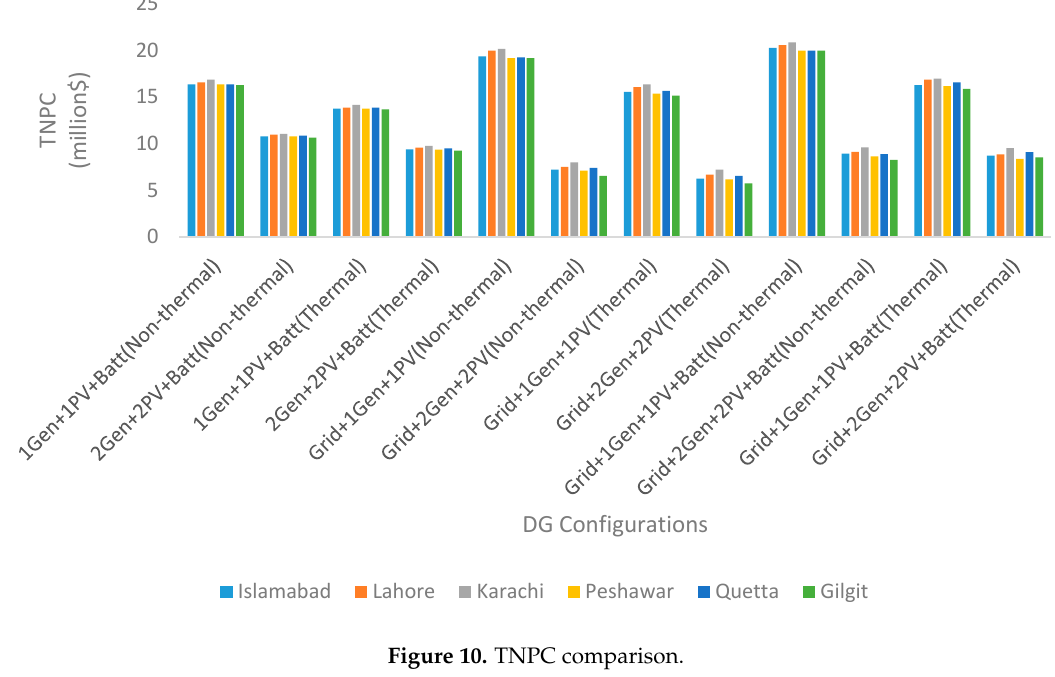
Figure 10. TNPC comparison.